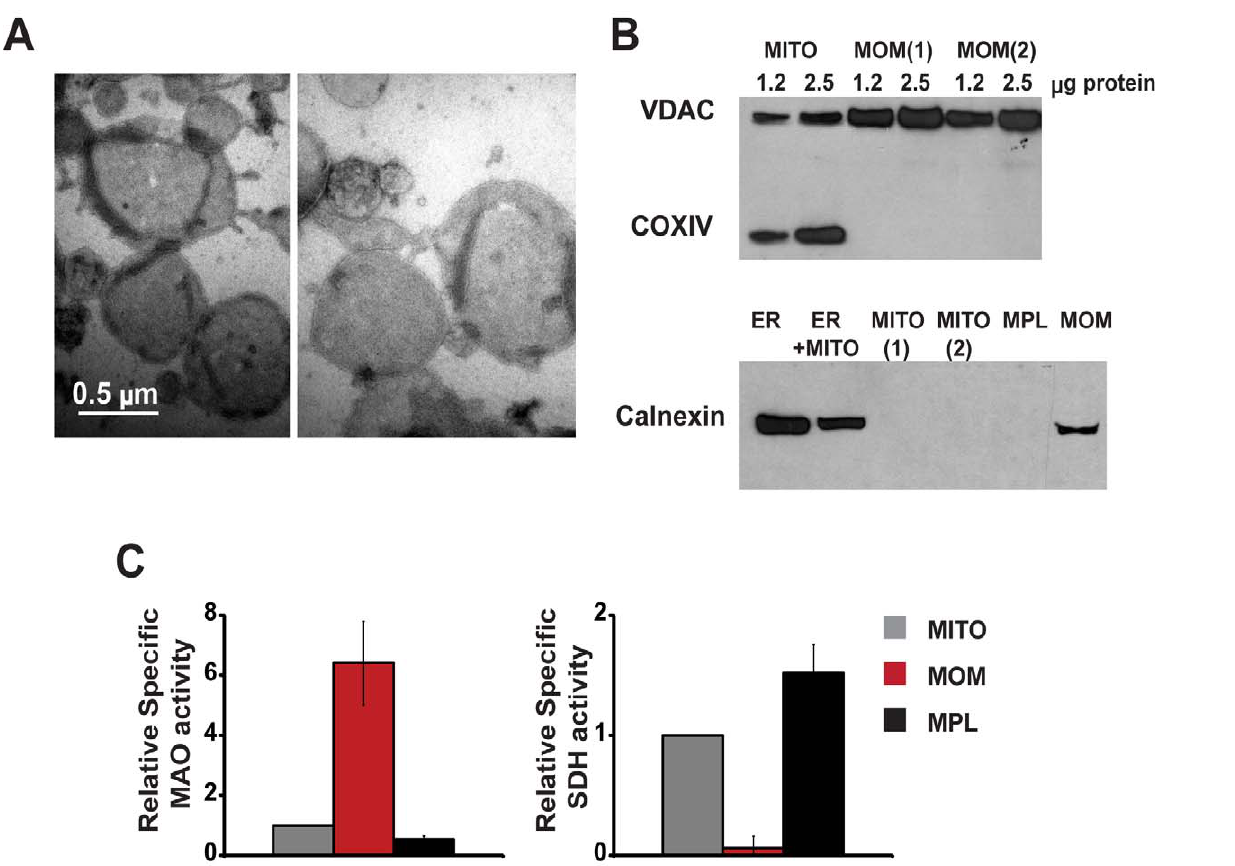
Figure 1. Mitochondrial outer membranes isolated from rat liver form vesicles that are essentially devoid of the mitochondrial inner membrane. Negatively stained outer membrane vesicles (OMVs) were visualized by electron microscopy (A). The purity of OMVs was evaluated by Western blot analysis (B) and by measurements of enzyme activities (C) of marker proteins: VDAC and monoaminooxidase (MAO) for the mitochondrial outer membrane (MOM); cytochrome c oxidase subunit (COXIV) and succinate dehydrogenase (SDH) for the inner membrane; and calnexin for the ER. Shown in (B) are mitochondria (MITO) and two preparations of MOM (upper panel); ER and light mitochondrial fraction (ER + MITO) in comparison with two preparations of mitochondria, mitoplasts (MPL), and MOM (lower panel). Samples were loaded at 2.5 m g of protein or as indicated. (C) Specific SDH and MAO activities in MOM and mitoplasts relative to the corresponding activities in whole mitochondria. Activities were measured in four to six preparations and data are presented as means 6